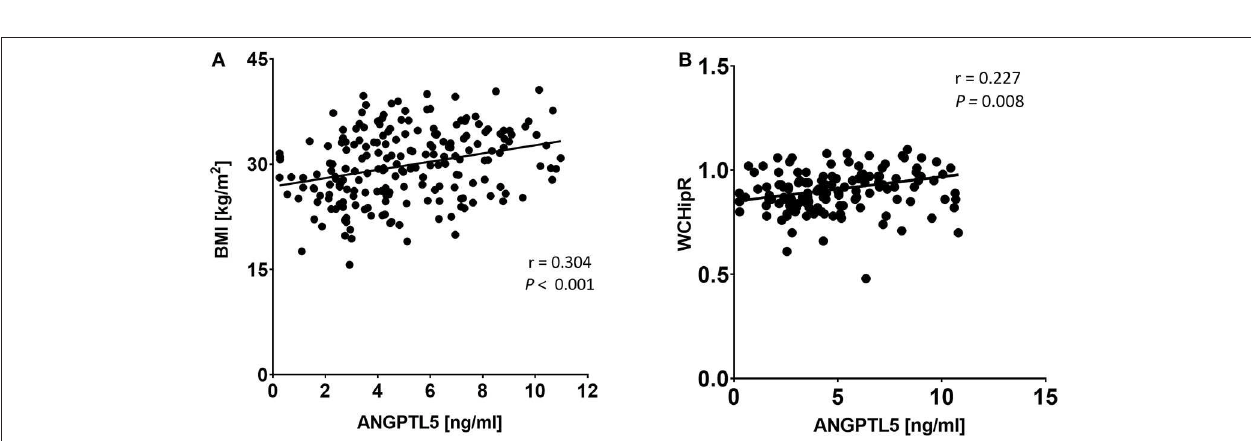
FIGURE 4 | Spearman’s correlation analysis of ANGPTL5 levels and BMI (A) and waist/hip ratio measurements (B) . P < 0.05 was considered significant as determined by Spearman’s correlation.